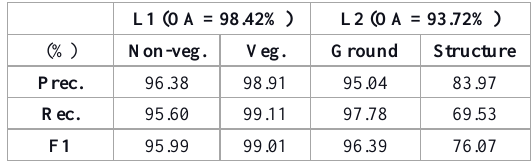
Table 1. Overall Accuracy (OA), Precision, Recall and F1-score metrics achieved for Dataset_1 at the first (L1) and second (L2) levels of semantic